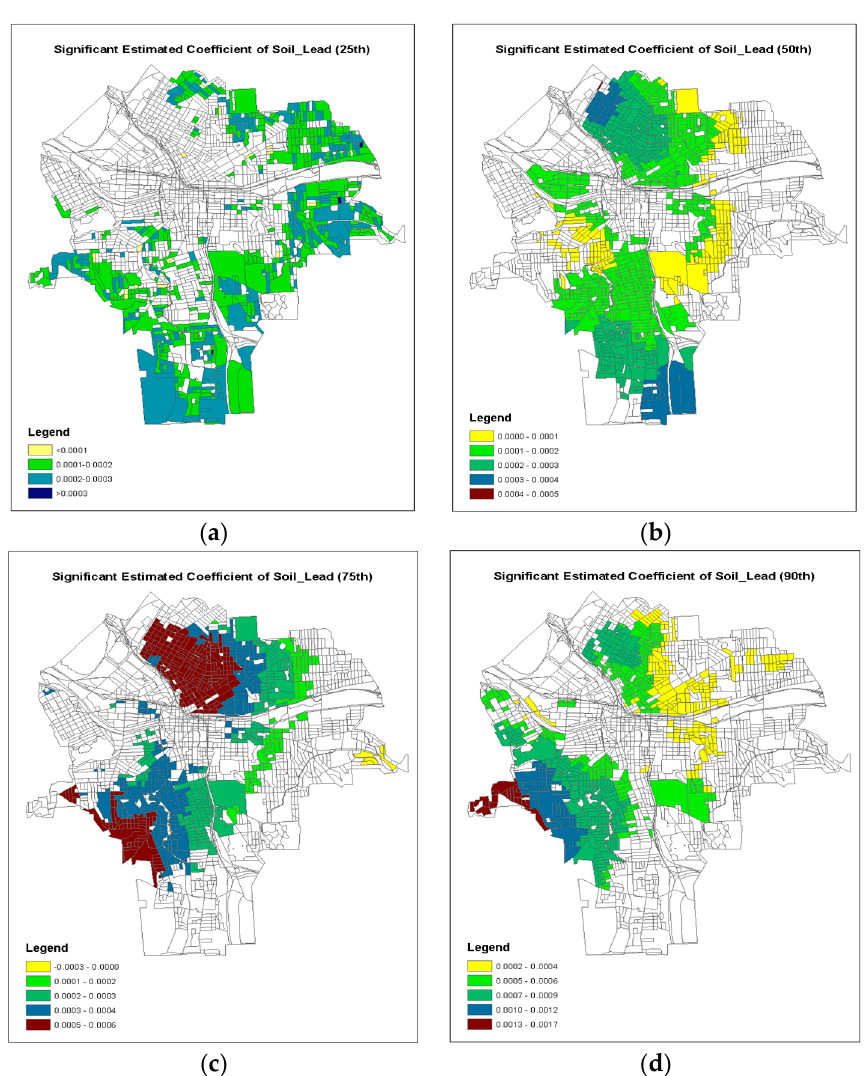
Figure 8. Geographical map of the significant coefficients (±1.96) of GWQR for Soil_Lead: ( a ) 25th; ( b ) 50th; ( c ) 75th; ( d ) 90th.